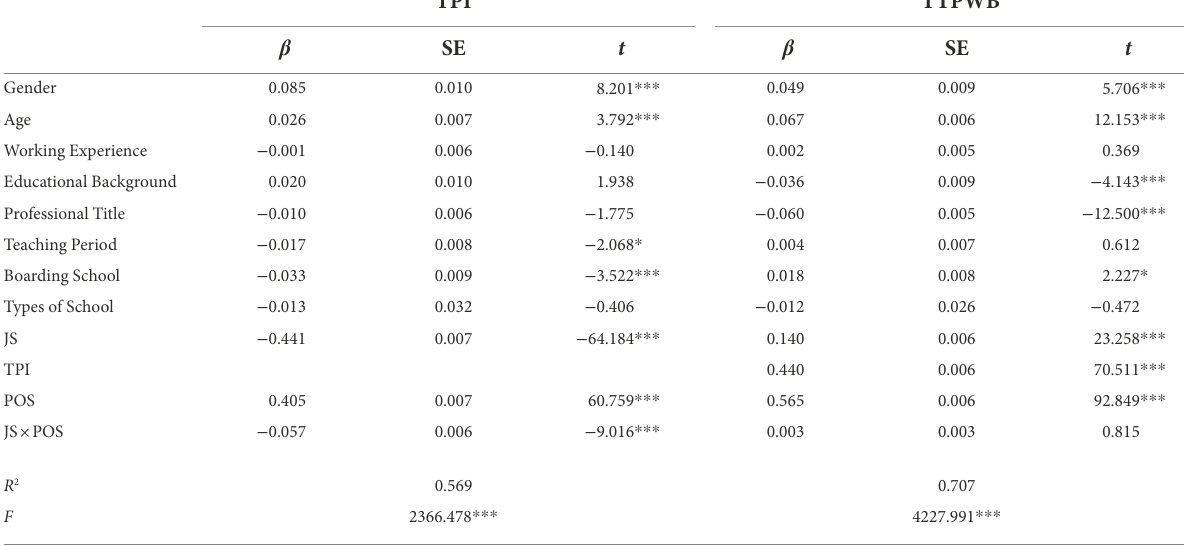
TABLE 3 Testing the moderated mediation effect of perceived organizational